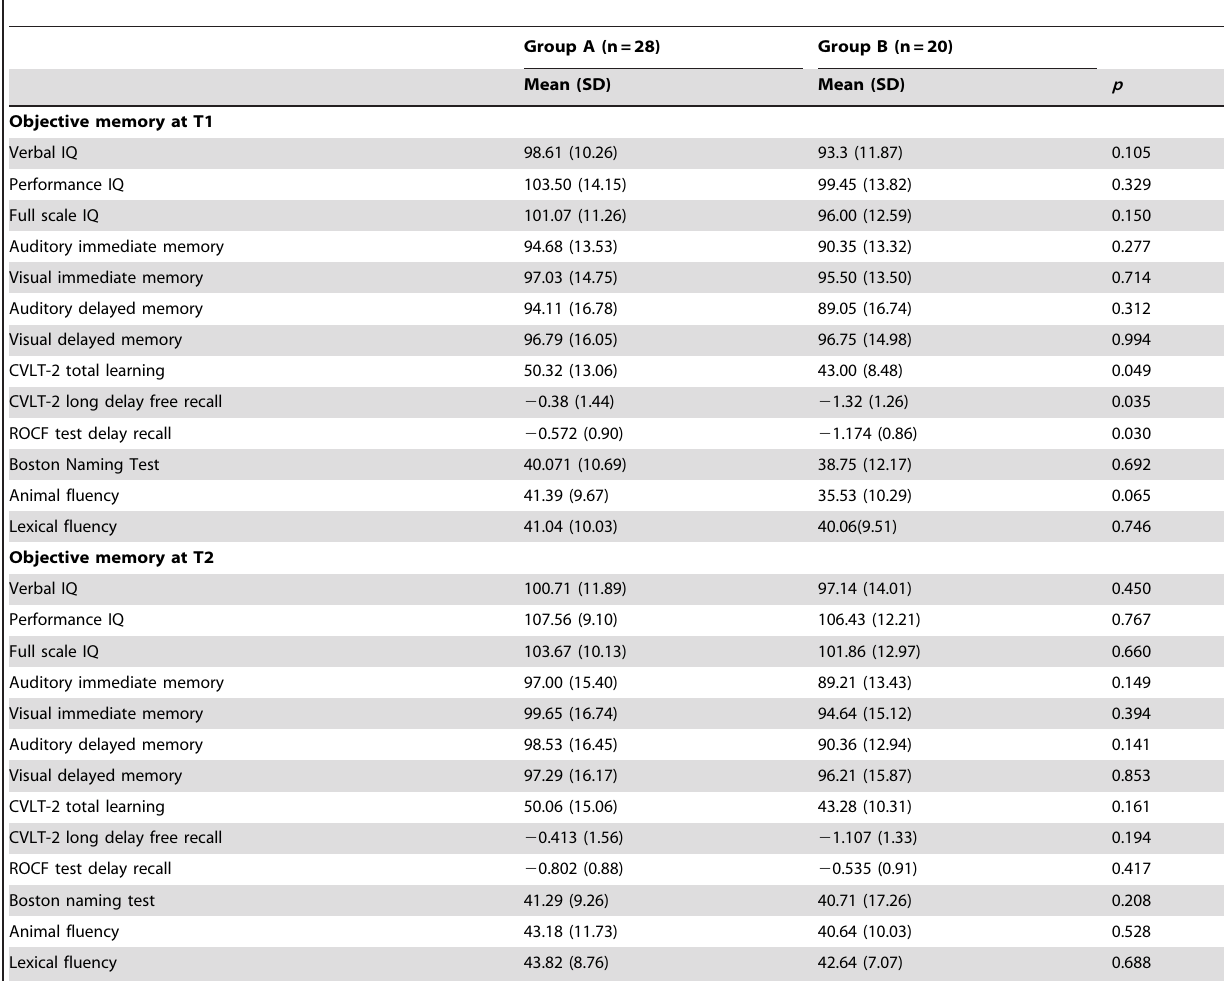
Table 3. Neuropsychological test performance for patients with stable or improved SM versus those with worsened SM 1 year